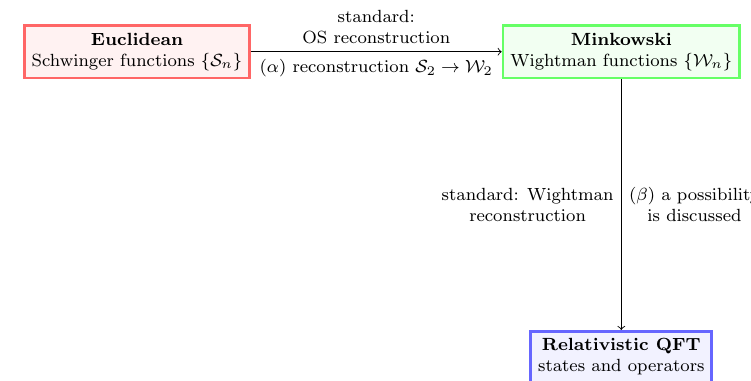
Figure 1: Conceptual picture describing methodology of how an analytic structure is investigated in the literature. Note that what we examine here is a structure on the complexified Euclidean momentum plane.